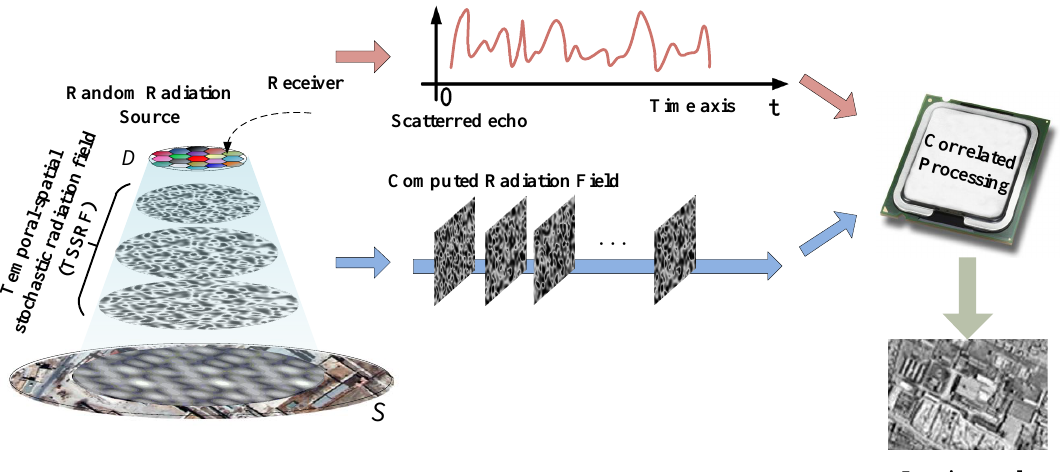
Figure 1. Procedure of Microwave Staring Correlated Imaging